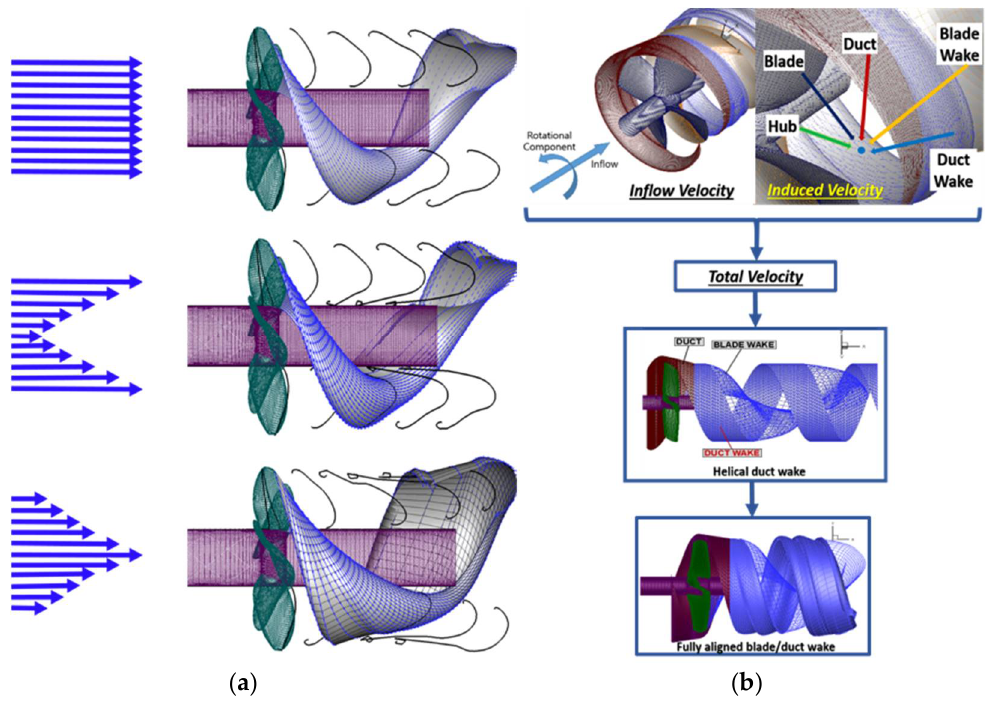
Figure 1. ( a ) Propeller under the axisymmetric inflow; ( b ) Contributors of the perturbation velocity on the wake surface, taken from Kim [12].